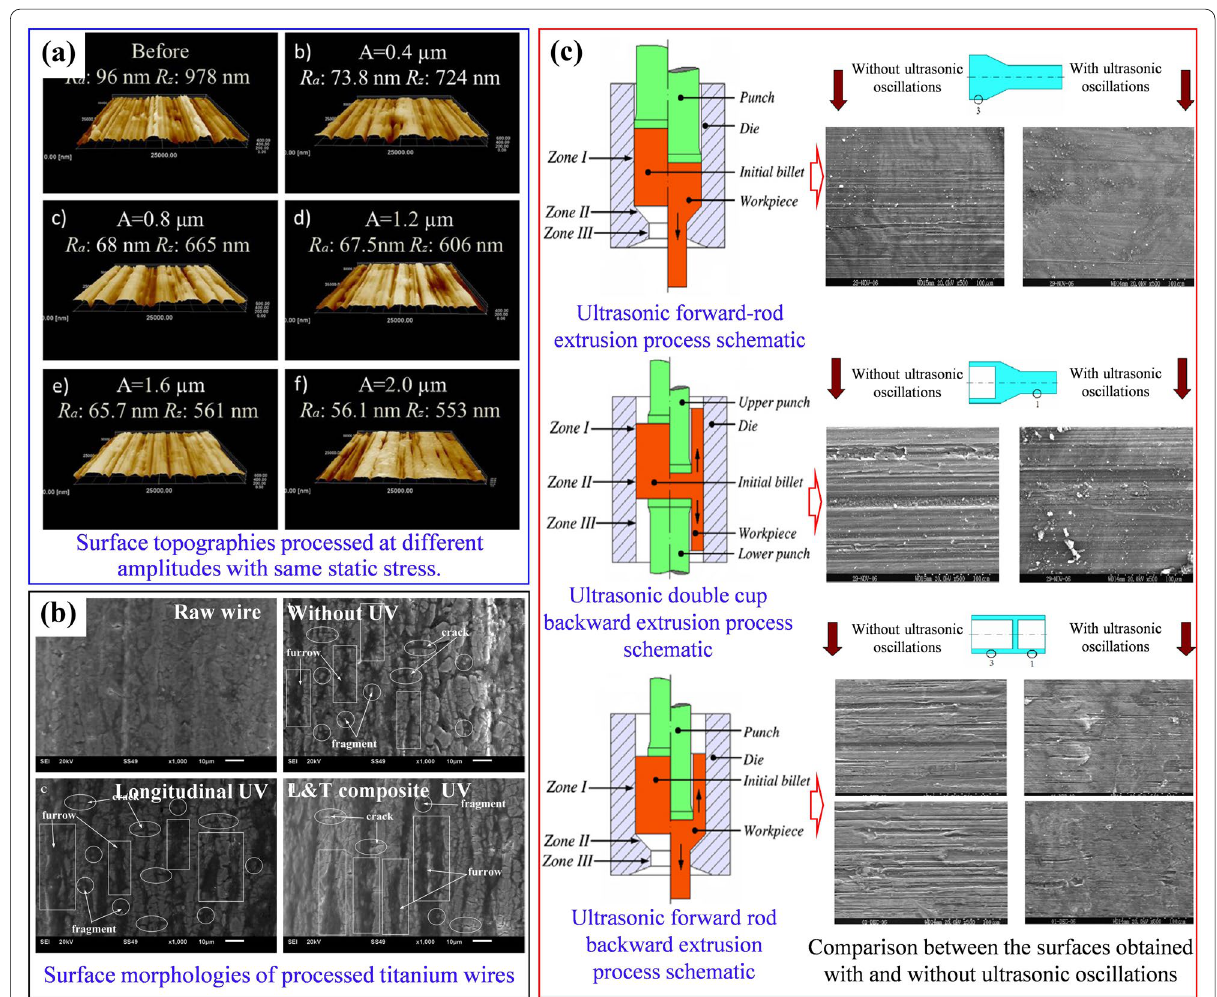
Figure 12 Effect of UV on surface quality: a upsetting [52], b wire drawing [81], c extrusion